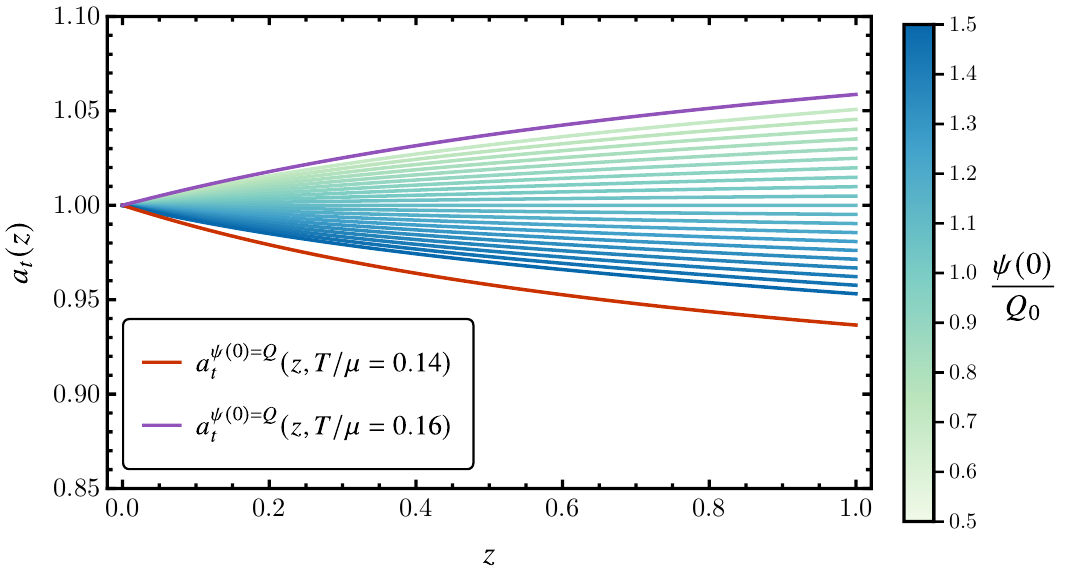
Figure 2 . Gauge field component a t ( z ) as defined in (4.1) at T 0 /µ = 0 . 15 and for various values of ψ (0) . We compare with the equivalent function a ψ (0)= Q of the aGR solution at different temperatures t T/µ = 0 . 16 (purple) and T/µ = 0 . 14 (red). This illustrates that qualitatively the effect of changing the dilaton boundary value has similarities to changing the ratio T/µ